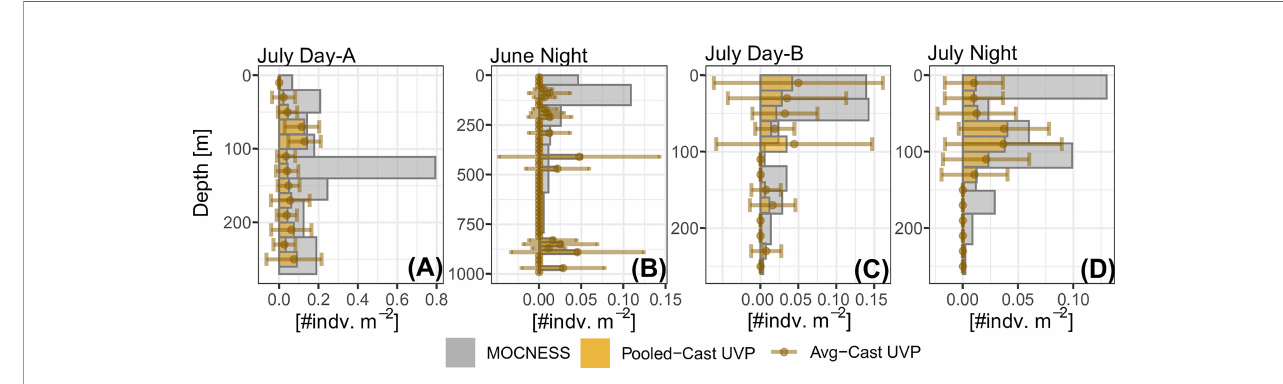
FIGURE 7 | Select pro fi les of taxa biomass concentration calculated from MOCNESS, pooled-cast UVP approach, and average-cast UVP approach. Pro fi les are selected to show examples for (A) copepods, (B) chaetognaths, (C) shrimp-like crustaceans, and (D) ostracod/cladocerans. All pro fi les can be seen in Supplemental Figure 7 .